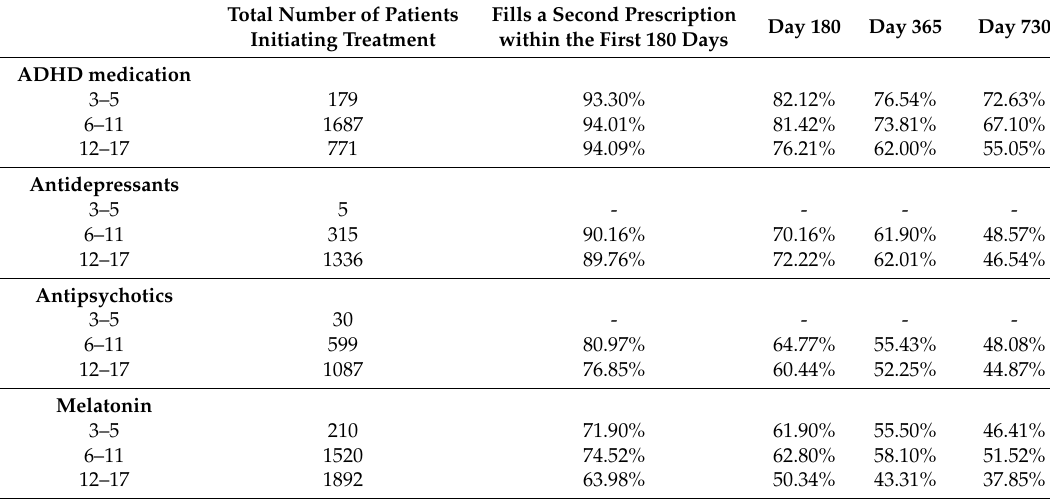
Table 2. Early discontinuation and persistence rate of ADHD medication, antidepressants, antipsychotics, and melatonin in children and adolescents 3–17 years old with ASD. Restricted to children initiating treatment between 2010 and 2015. For melatonin, the analysis is restricted to patients initiating treatment 2012–2015.